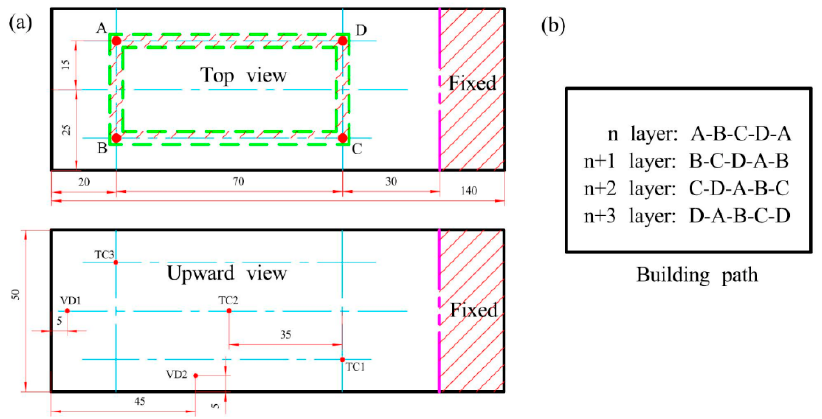
Figure 2. Rectangular part: ( a ) part dimensions (mm) and locations of the thermocouples and displacement sensors; ( b ) building path. Table 1. Processing parameters of laser directed energy deposition (L-DED). Case